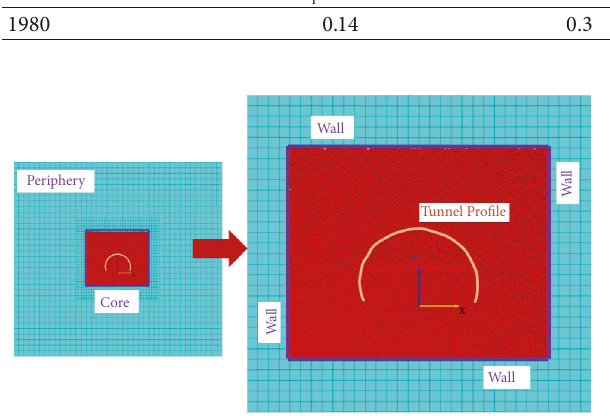
Figure 5: Stratum scale model.